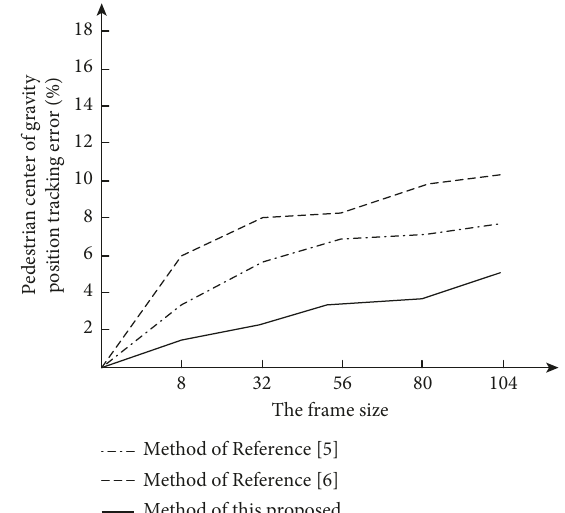
Figure 4: Comparison of pedestrian barycenter position tracking errors of different